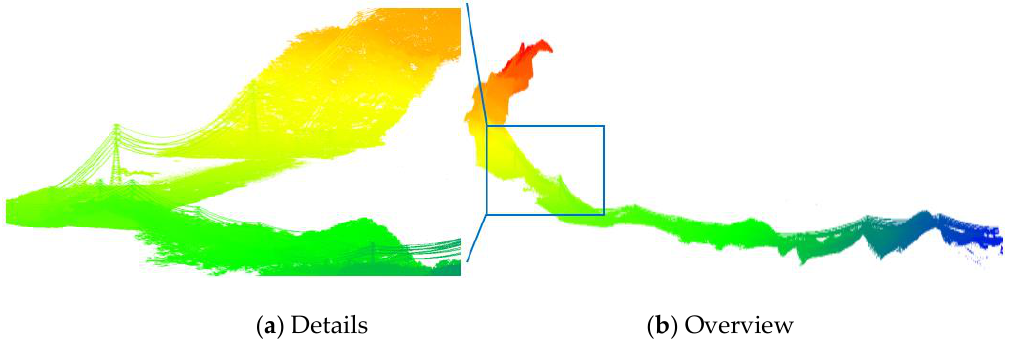
Figure 9. Raw ROW 2 point clouds (rendered with height).